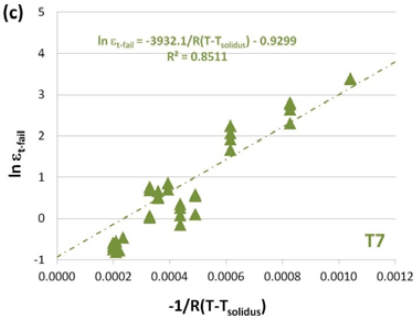
Figure 5. Arrhenius ‐ like dependence of true failure strain ( ε t − fail ) for Al ‐ A319 alloys in ( a ) as ‐ cast; ( b ) W; and ( c ) T7 heat treatment conditions. Symbols represent experimental data and the lines are the prediction of the model, respectively.